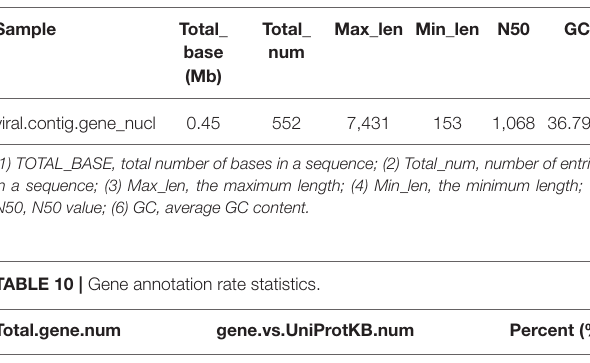
TABLE 12 | Statistical analysis of total length and similarity of